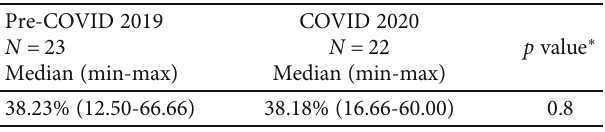
Table 3: A comparison of cecal intubation rates in screening colonoscopies between the pre-COVID and COVID time periods. Colonoscopies with successful intubation ( N /percent) Table 4: A comparison of adenoma detection rates between the pre- COVID-19 (2019) and COVID-19 (2020) time